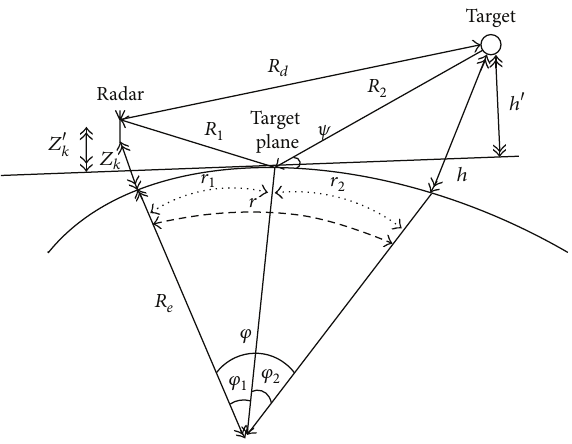
Figure 1: Multipath geometry for a curved